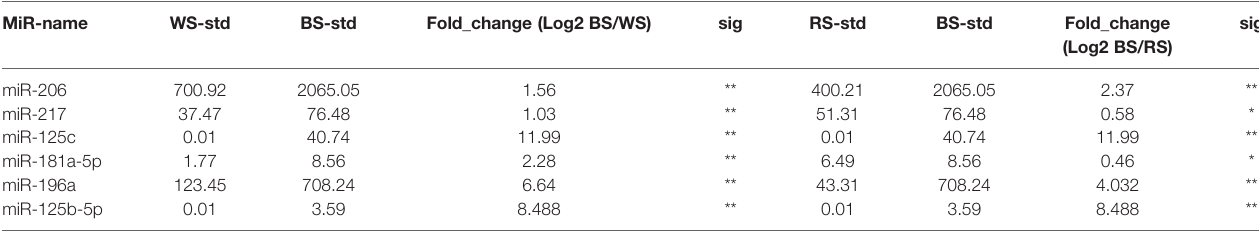
TABLE 1 | Differentially expressed miRNAs among three skin